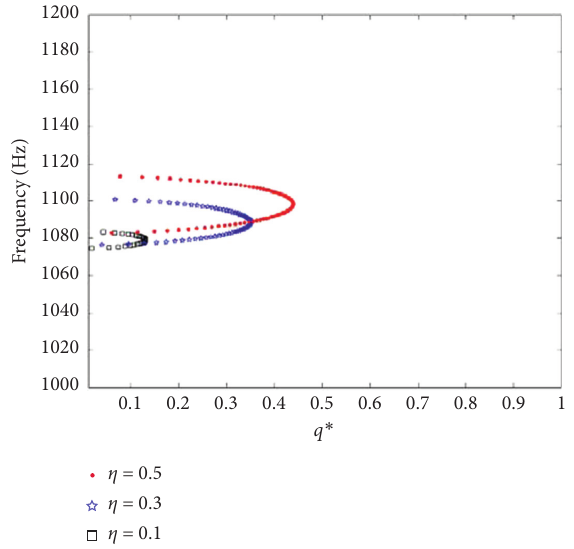
Figure 6: The first Bragg band structures in pure resistance and pure inductance circuit with η � 0.1, η � 0.3, and η �